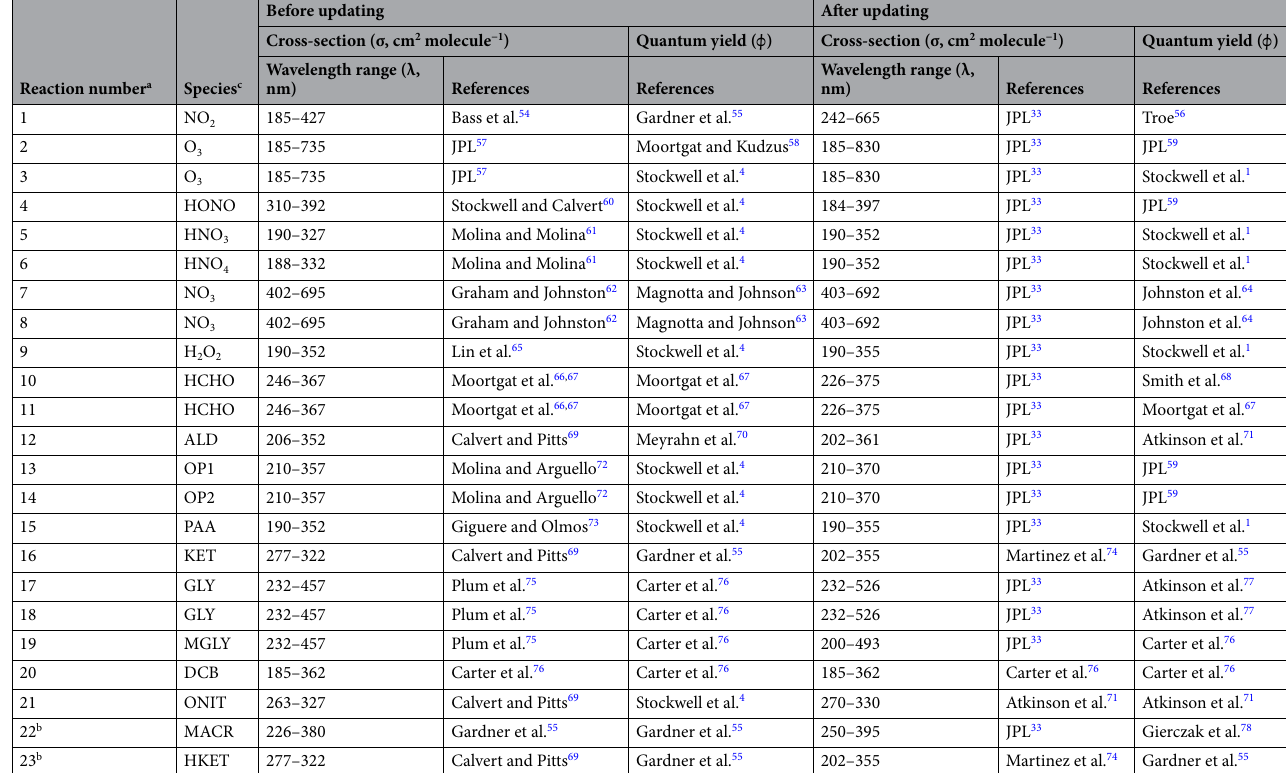
Table 1. List of the changes in wavelength, cross-section and quantum yield before and after updating. a The reaction number corresponds to the photolysis reaction in Stockwell et al. 1 . b Reactions are only applied in RACM 1 . c Please refer to Table 2 for the